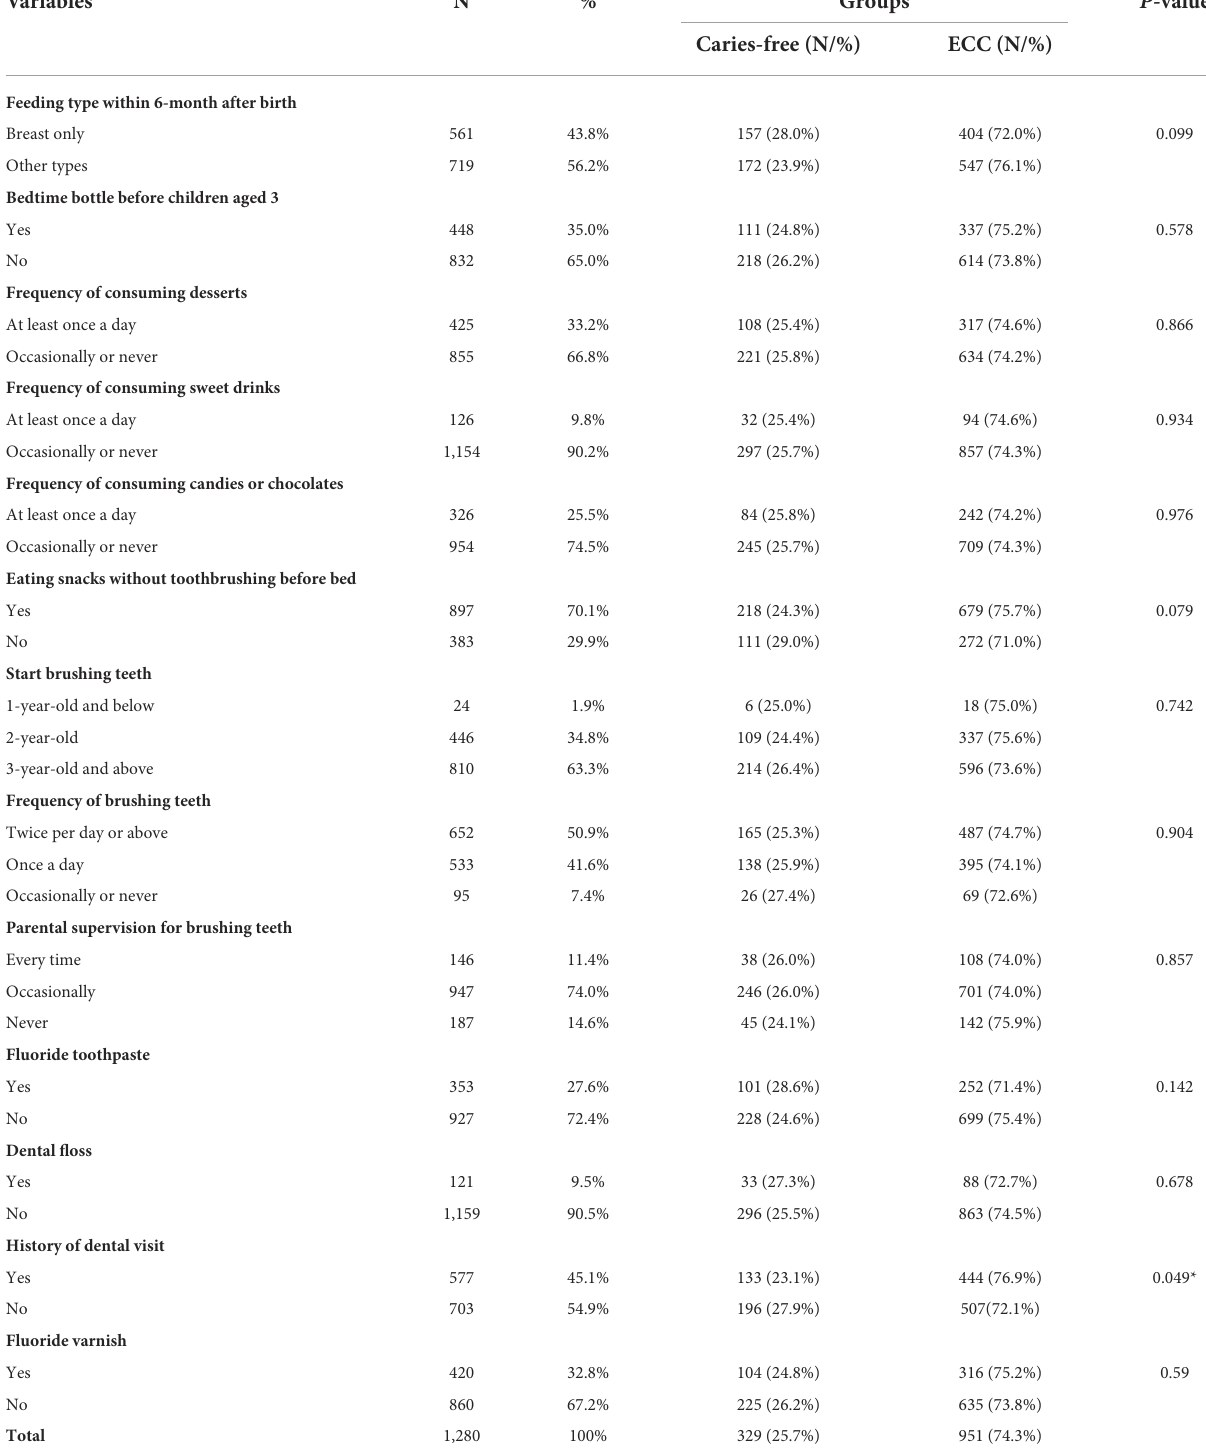
TABLE 2 Prevalence of ECC and feeding history, dietary habit, oral hygiene behaviors and dental history ( N = 1280). Variables N % Groups P -value Caries-free (N/%) ECC